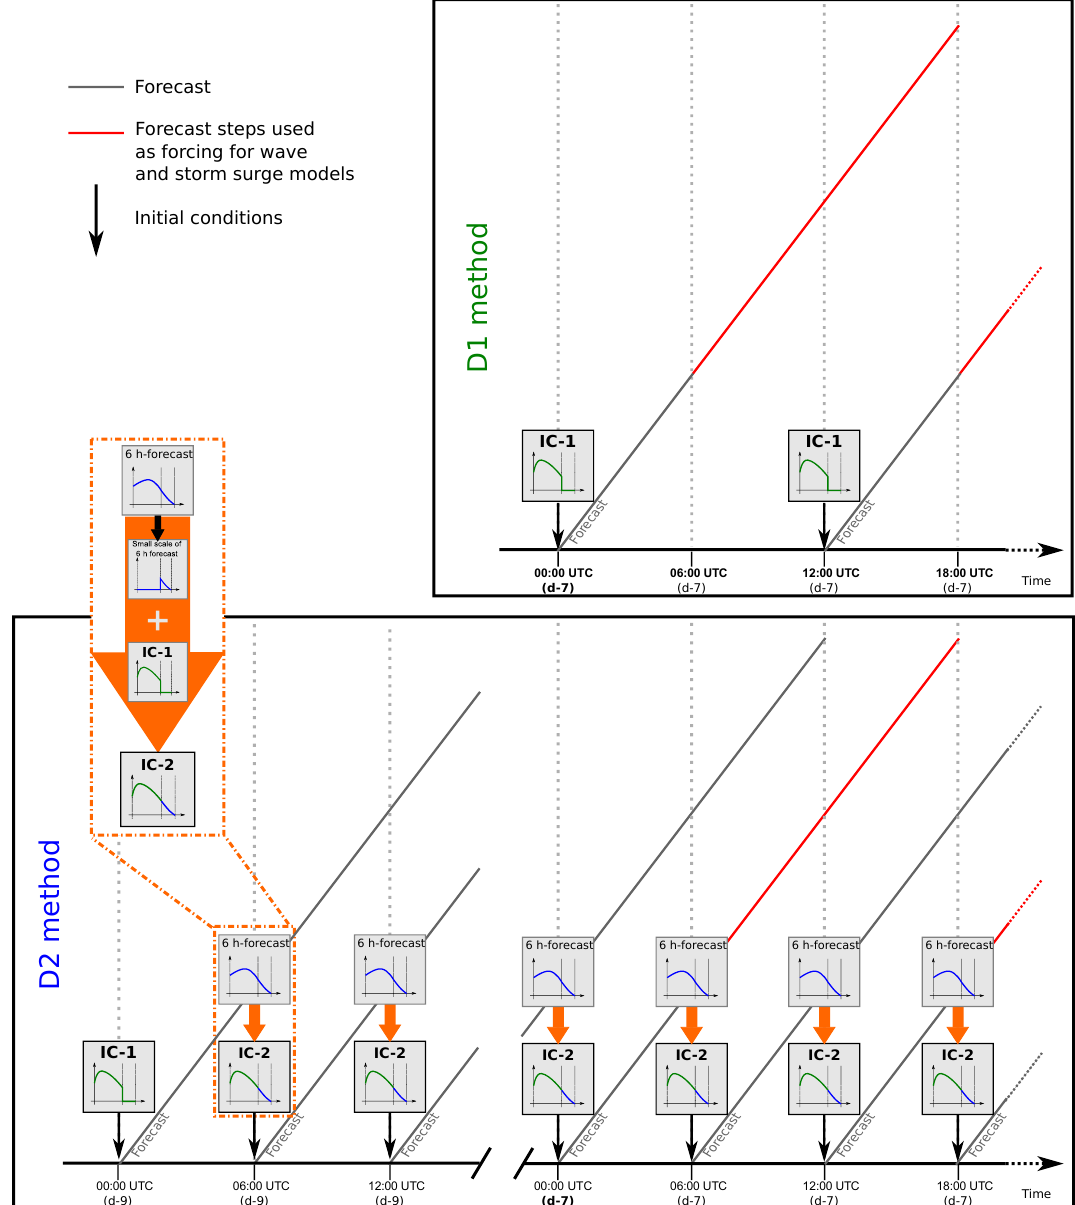
Figure 1. Schematic representation of D1 and D2 techniques. Energy spectra are within the small images. The red parts of forecast are the forecast data used as input forcing in the wave and storm surge